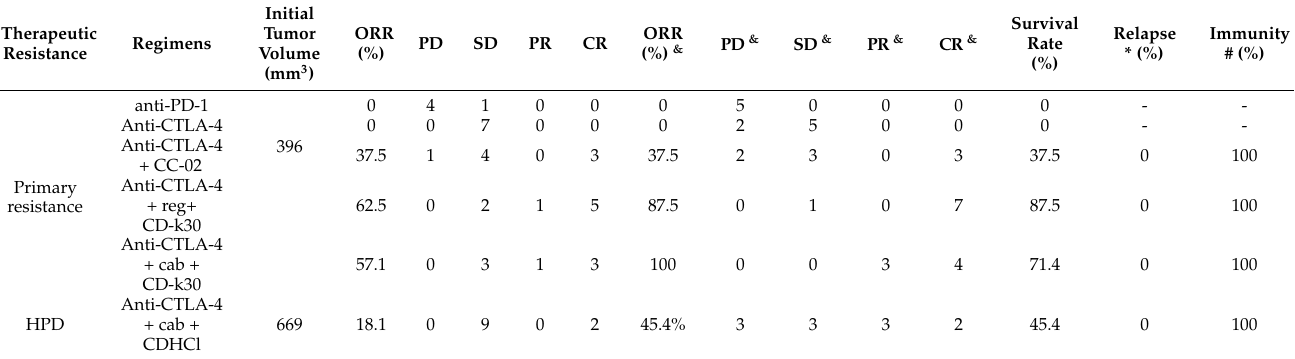
Table 4. Response rates after treatment with different second-line regimens in CT26-bearing mice with primary resistance, acquired resistance, or HPD to first-line anti-PD-1 antibody